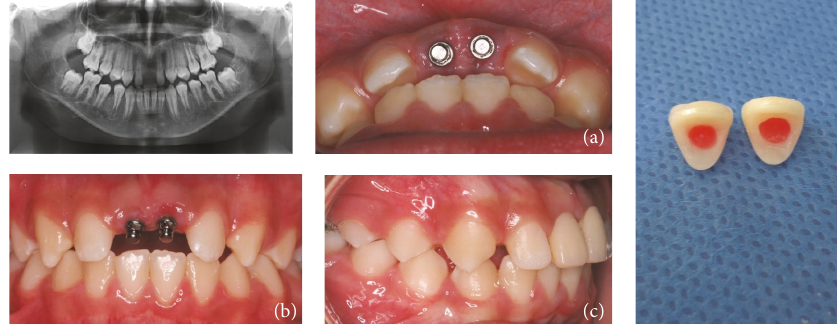
Figure 3: Edentulous region after mini-implants insertion ((a) and (b)); temporary crowns adapted to the heads of the mini-implants (c).